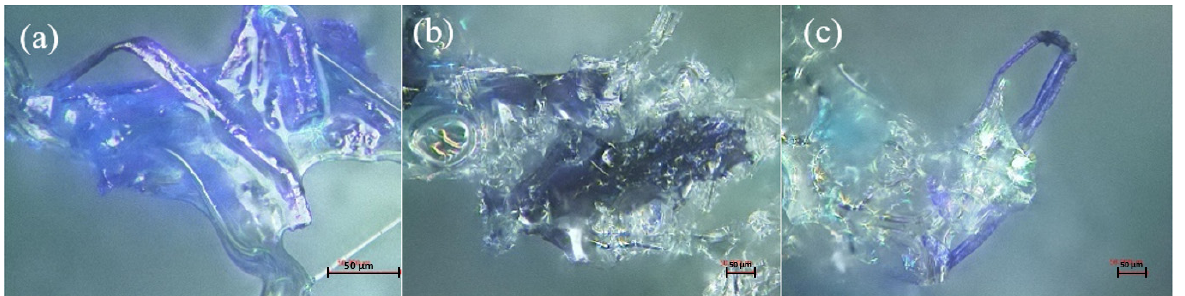
Figure 8. Effect of fiber treatment on reinforced foam properties: ( a ) density, ( b ) compressive strength.